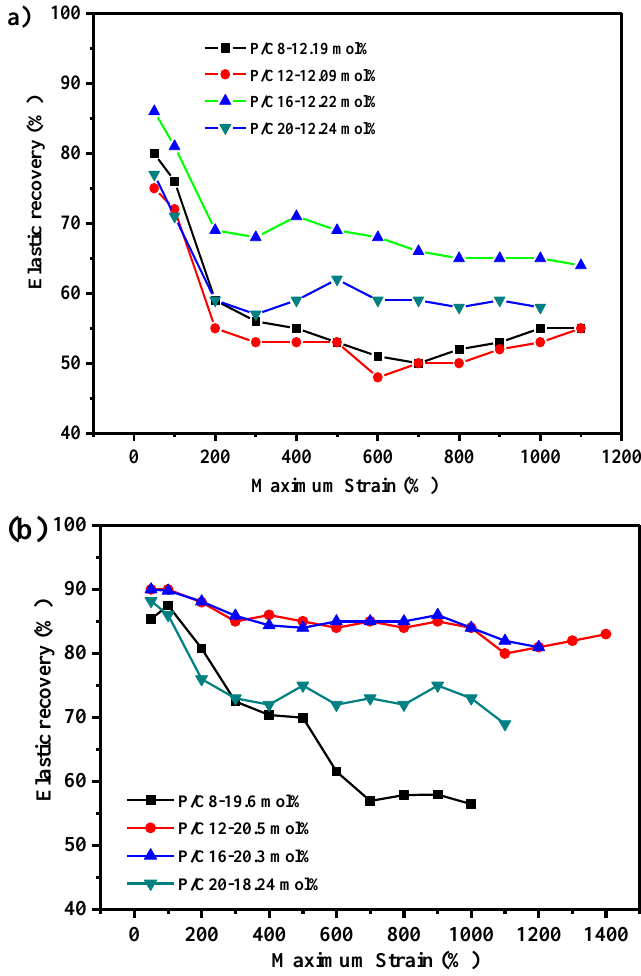
Figure 4. Elastic recovery of the poly (propene- co -α-olefin) copolymers containing about 12 mol.% ( a ) and 20 mol.% ( b ) of high α-olefin comonomers.